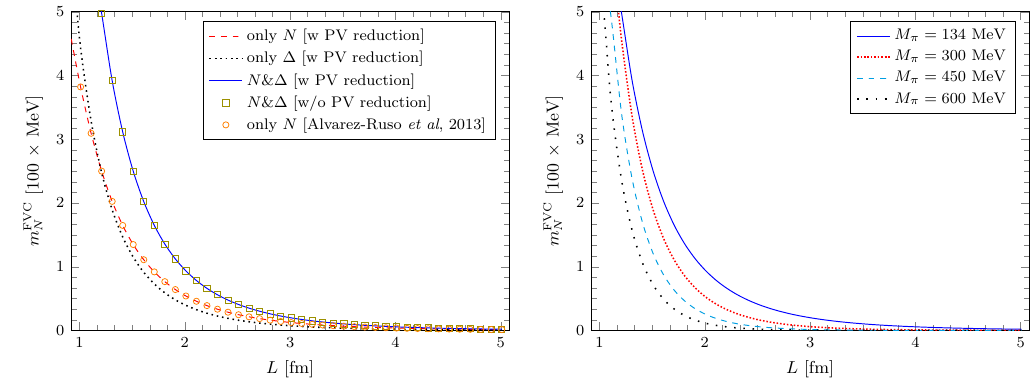
Figure 5 . Left panel: FVC to the nucleon mass. Right panel: the L -dependence of the nucleon mass with various values of the pion